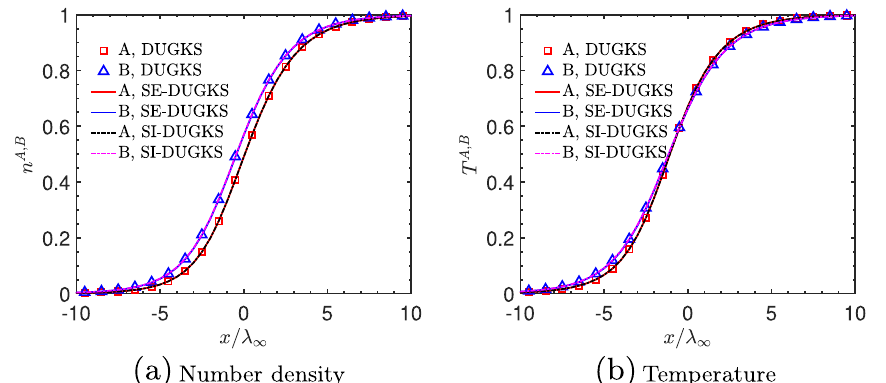
Fig. 3 Shock structure with Ma − = 1.5 , m B ∕ m A = 0.5 , and 𝜒 A =